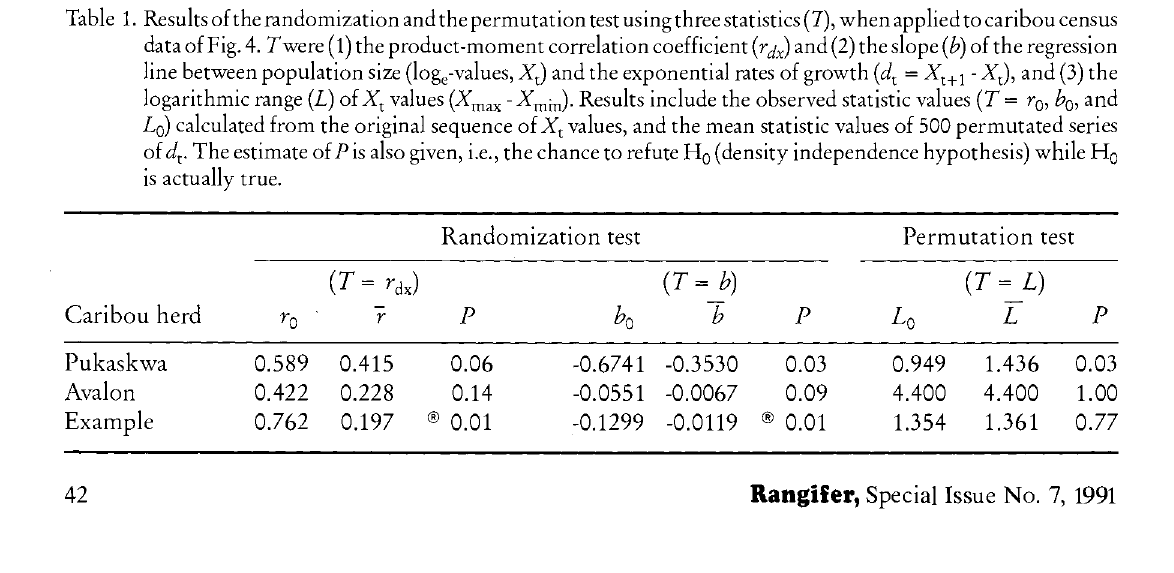
Table 1. Results of the randomization and the permutation test using three statistics (7), when applied to caribou census data of Fig. 4. Twere(l) the product-moment correlation coefficient (r^) and (2) the slope (b) of the regression line between population size (log e -values, X t ) and the exponential rates of growth (d t = X [+1 - X t ), and (3) the logarithmic range (L) of X t values (X m!lx - X mm ). Results include the observed statistic values (7* = r 0 , b 0 , and LQ) calculated from the original sequence of X t values, and the mean statistic values of 500 permutated series of d v The estimate of .Pis also given, i.e., the chance to refute H 0 (density independence hypothesis) while H 0